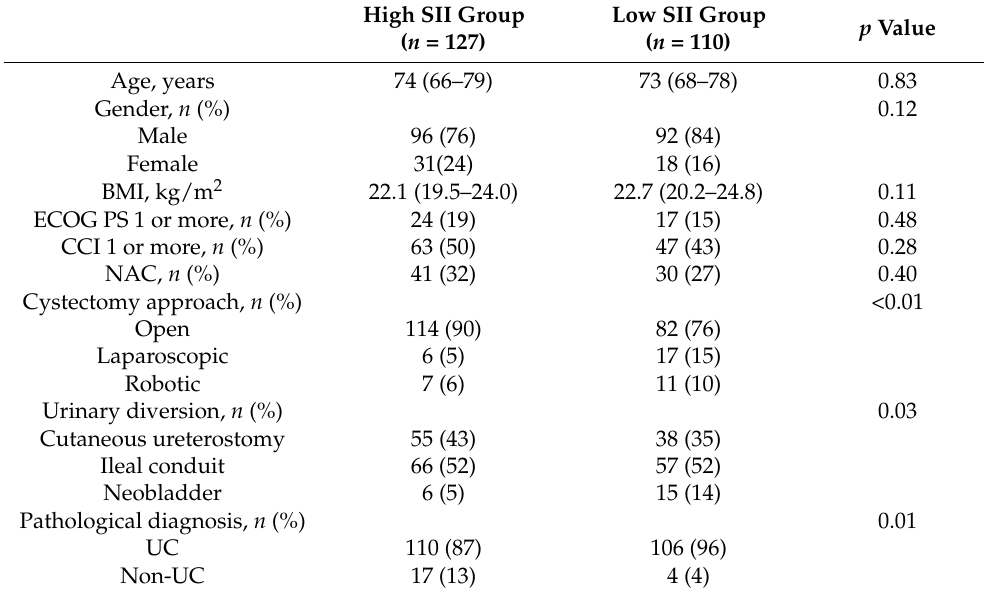
Figure 1. ROC curves of NLR, PLR and SII for CSS. Table 2. Comparison of patient demographics between patients with high SII and those with low SII .